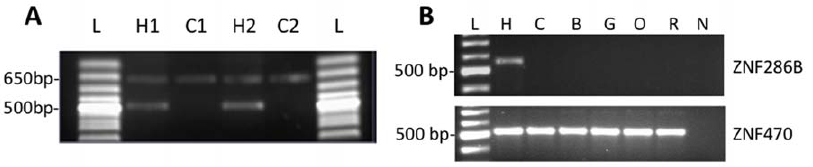
Figure 3. Confirming the human specificity of ZNF492 and ZNF286B genes. A. ZNF492 is predicted to be a human specific duplication of ZNF98 and can be distinguished from ZNF98 by several sequence differences, including one mutation that creates a Bsm I restriction site in the human-specific gene. We generated PCR products from two independent human (H1, H2) and chimpanzee (C1, C2) genomic DNA samples using primers that would amplify 650 bp regions from both genes and digested the products with Bsm I (L=size standard ladder). As predicted, the chimpanzee DNA was not cut by Bsm I. By contrast, the human sequence gives rise to three Bsm I bands, including the undigested 600 bp ZNF98 sequence along with 500 bp and 150 bp fragments corresponding to the digested ZNF492 paralog. The gel shown here was run maximize separation of the 600 and 450 bp bands; the 150 bp fragment is not shown. B: ZNF286B is predicted to be a human-specific duplicate of ZNF286A . We used PCR with the forward primer targeting the first finger that distinguishes the two paralogs to amplify the 286B gene sequences in genomic DNA from six primates: human (H), Chimpanzee (c), Bonobo (B), Gorilla (G), Orangutan (O), and rhesus macaque (R). A size standard ladder (L) and no-template negative control (N) are also included. A ZNF286B -specific PCR product was generated only in human DNA. These same DNA preparations were tested with control PCR primer sets designed against several other genes including ZNF470, which is known to be present in all species (lower panel). The production of clear PCR products for this and other shared genes confirmed the quality of the non-human primate